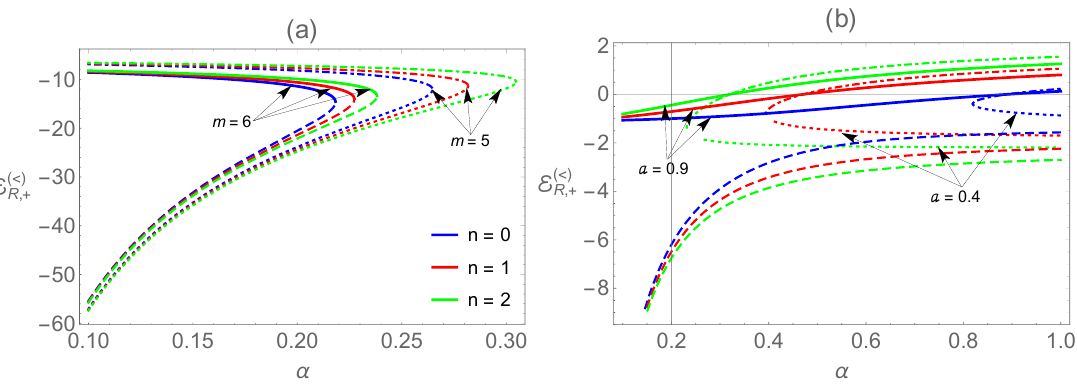
( < ) (Equation (71)) as a function of α . In ( a ), a = 0.8, ω = 2 and R , +